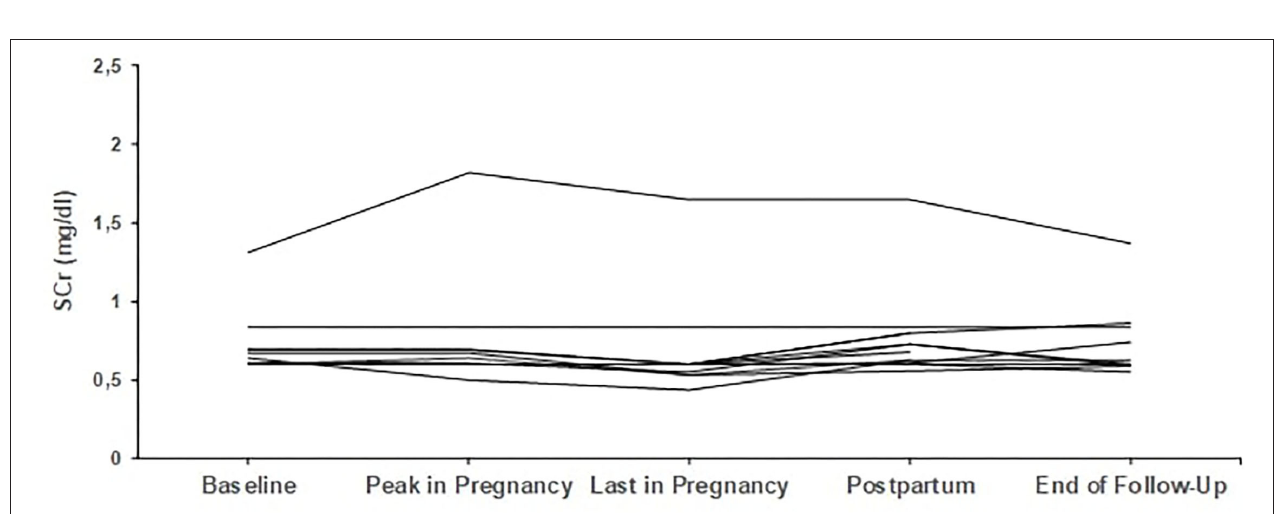
FIGURE 2 | Trends in creatinine in patients with secondary glomerular diseases ( n = 9). Individual trends in serum creatinine levels at five time points: baseline, peak during pregnancy, last pregnancy visit, postpartum, and end